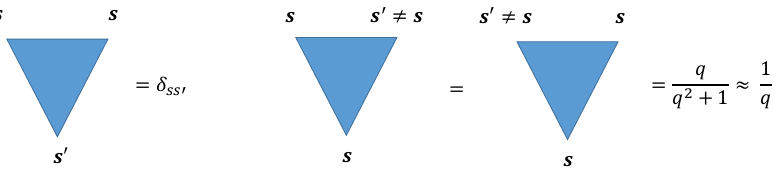
Figure 21 . Interactions among the bulk spins, with s, s 0 taking values in ↑ , ↓ . These rules will also apply to the interactions along the top boundary for observables in appendix A.2 and